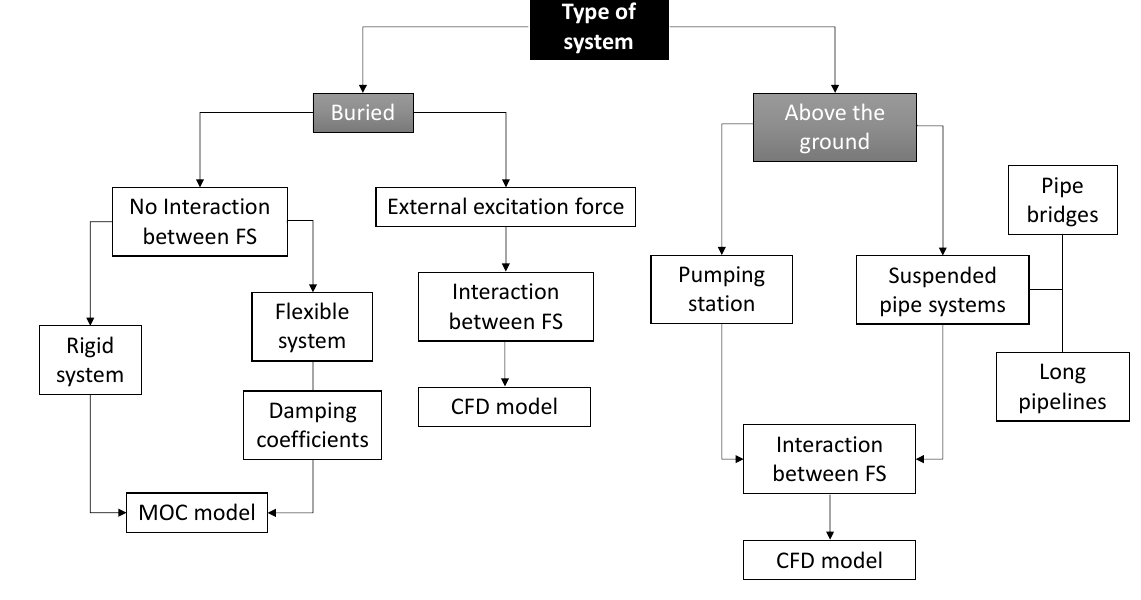
Figure 28. Relevance of the system type and dynamic